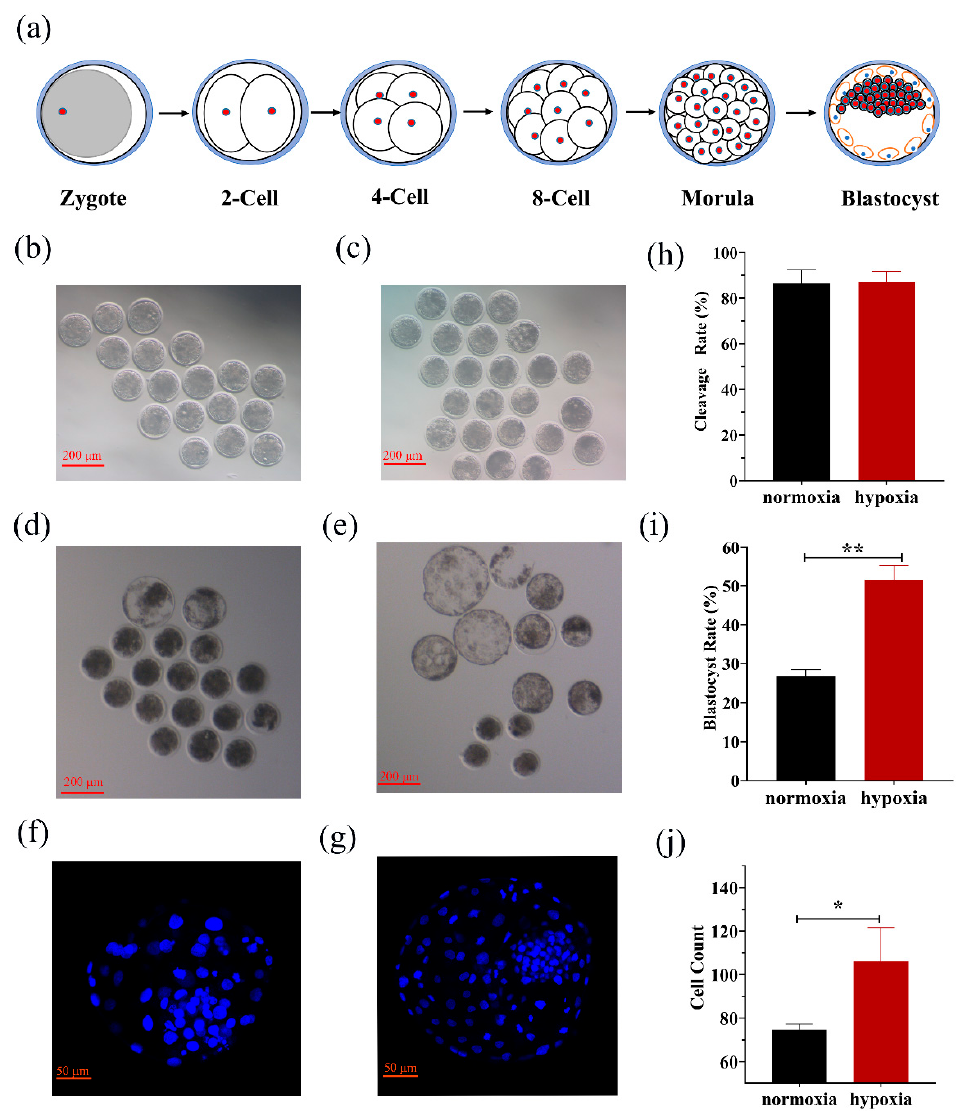
Figure 1. The stages of early embryonic development. ( a ) Six key stages of embryonic development including zygote, 2-cell, 4-cell, 8-cell, morula, and blastocyst stages. Fertilized embryos were cultured to the 8-cell stage ( b ) and blastocyst stage ( d ) in normoxic conditions and to the 8-cell stage ( c ) and blastocyst stage ( e ) in hypoxic conditions. The images ( f , g ) were captured with a microscope (LSM 700 META; Zeiss, Jena, Germany). The cleavage rate ( j ) was not significantly different under hypoxic conditions compared to that of normoxic conditions, but the blastocyst rate ( h ) and cell count ( i ) were significantly increased compared to those in the normoxic conditions. Embryonic development data were collected under hypoxic (n = 71) and normoxic (n = 60) conditions. * p < 0.05, ** p < 0.01.